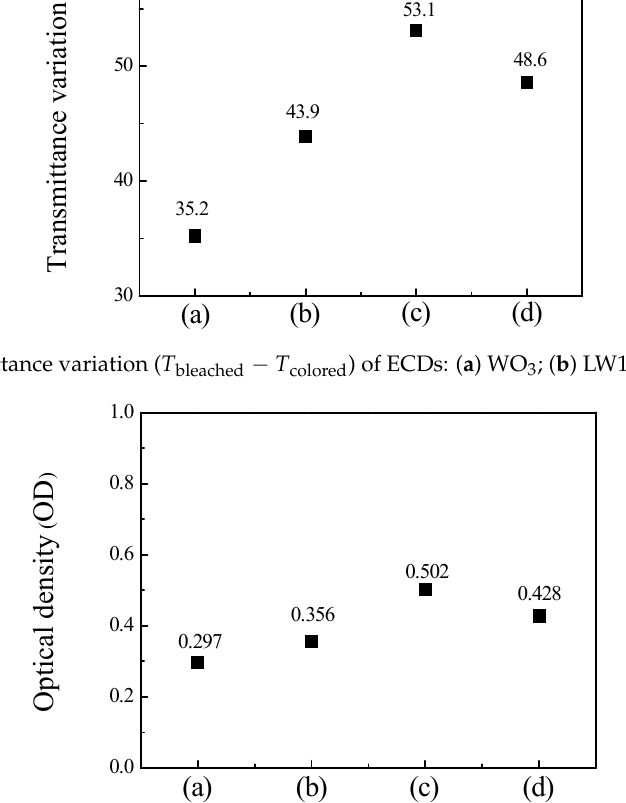
Figure 8. Optical density of ECDs: ( a ) WO 3 ; ( b ) LW1; ( c ) LW2; ( d ) LW3.